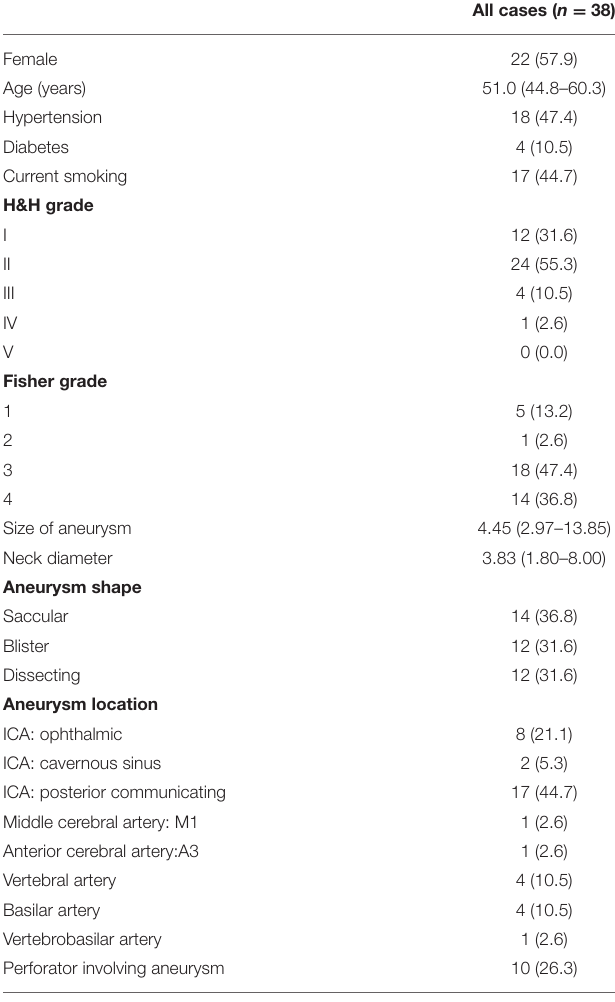
TABLE 1 | Patient and aneurysm